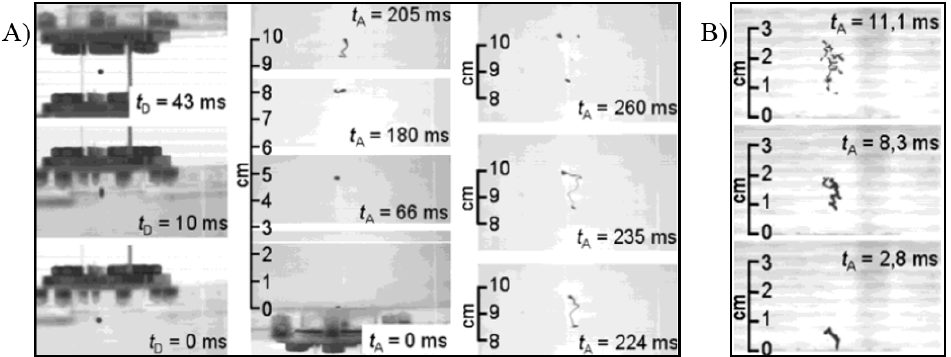
Figure 1. Droplet deformation and break-up in a simple orifice: ( A ) the droplet “separation” into three daugther droplets at a Reynolds number of Re ≈ 1300; and ( B ) the “explosive droplet disruption” at a Reynolds number of Re ≈ 4500. Reproduced with the permission from [25]; Wiley, 2001.